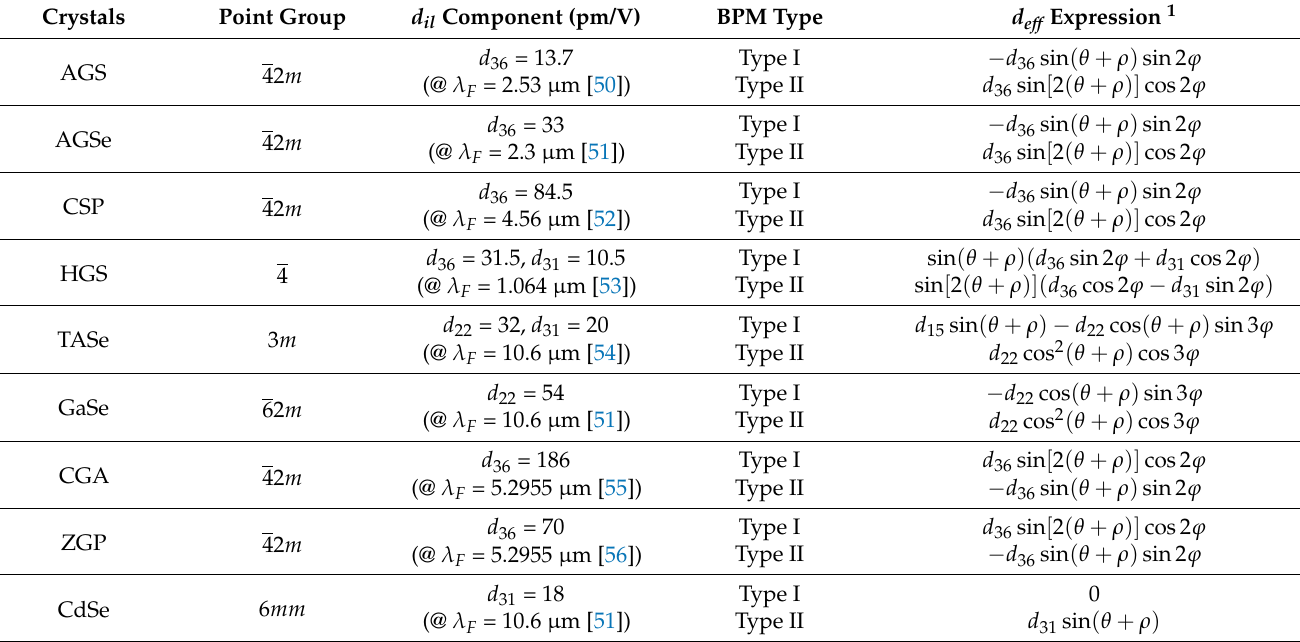
Table 4. Effective NLO coefficients ( d eff ) of chalcopyrite crystals showing uniaxial birefringence.